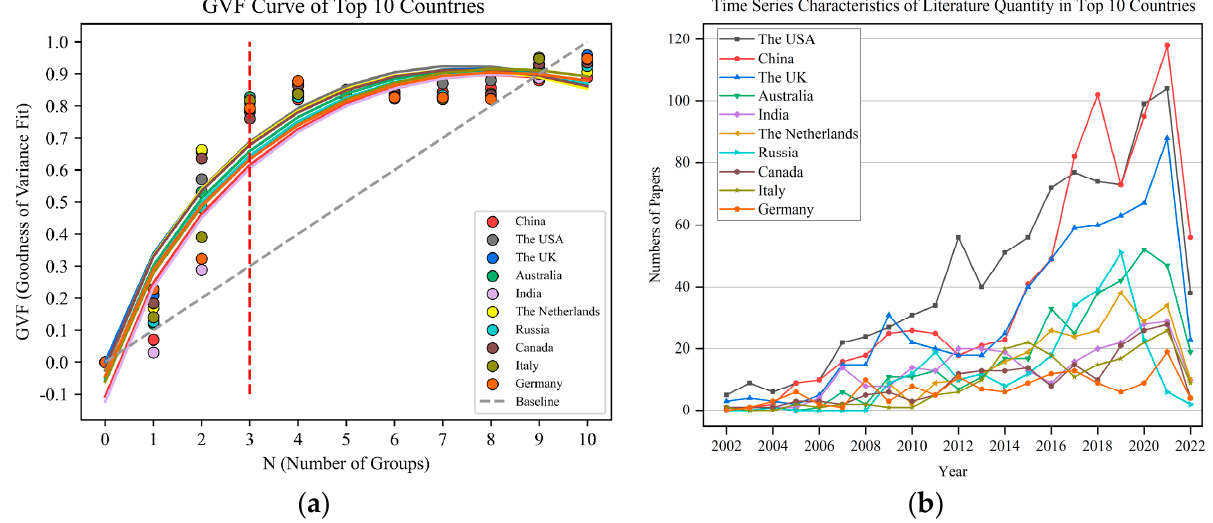
Figure 3. National literature comparison and GVF test ( a ) GVF Curve of Top 10 Countries; ( b ) Time Series Characteristics of Literature Quantity in Top 10 Countries.